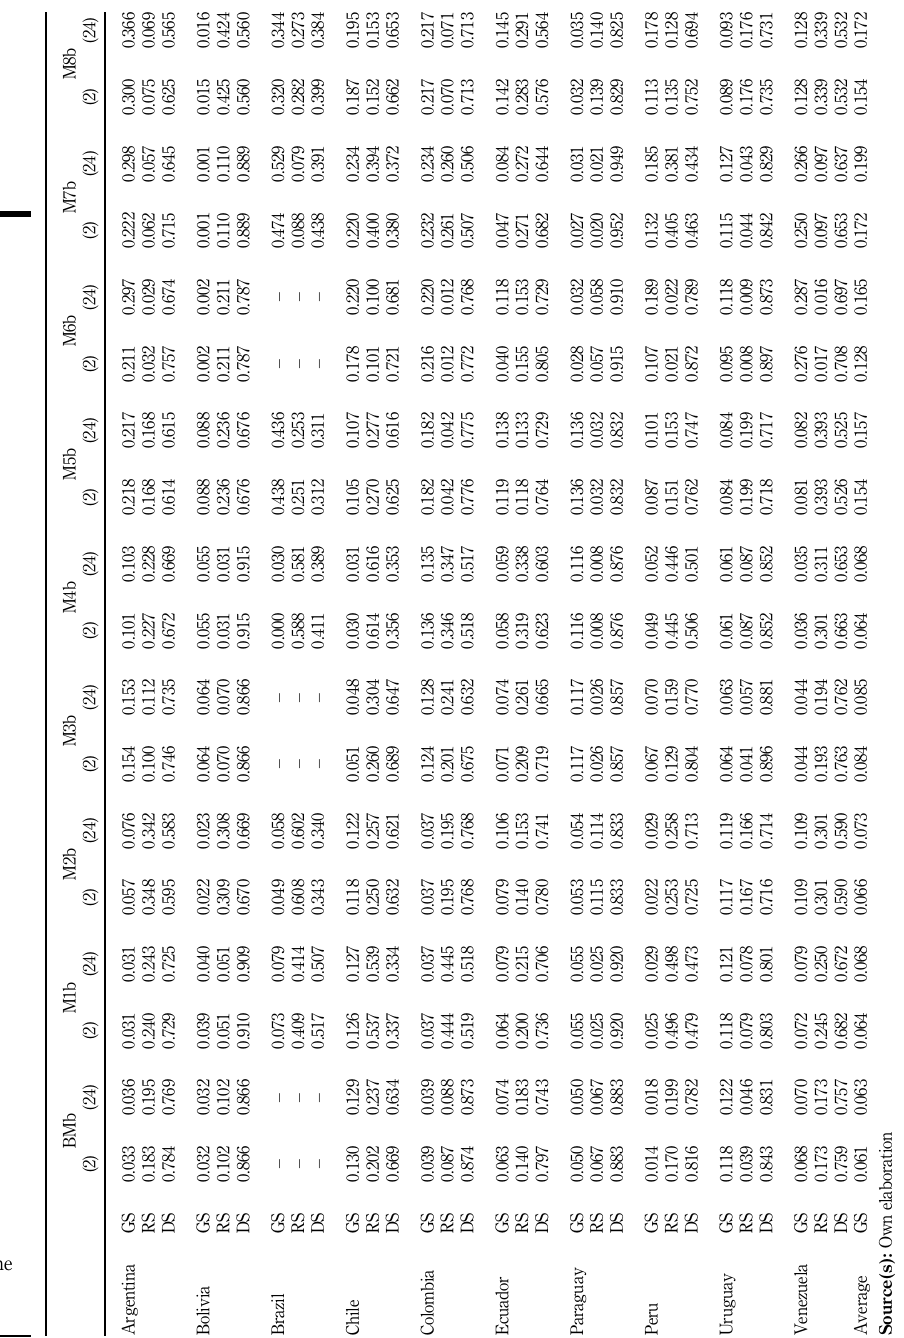
Table 5. Variance decomposition in the alternative models for